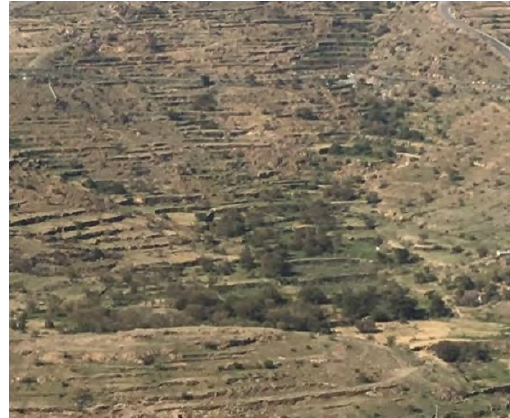
Figure 2. Traces and agricultural debris on the slopes of mountains irrigated with rain water (Source: